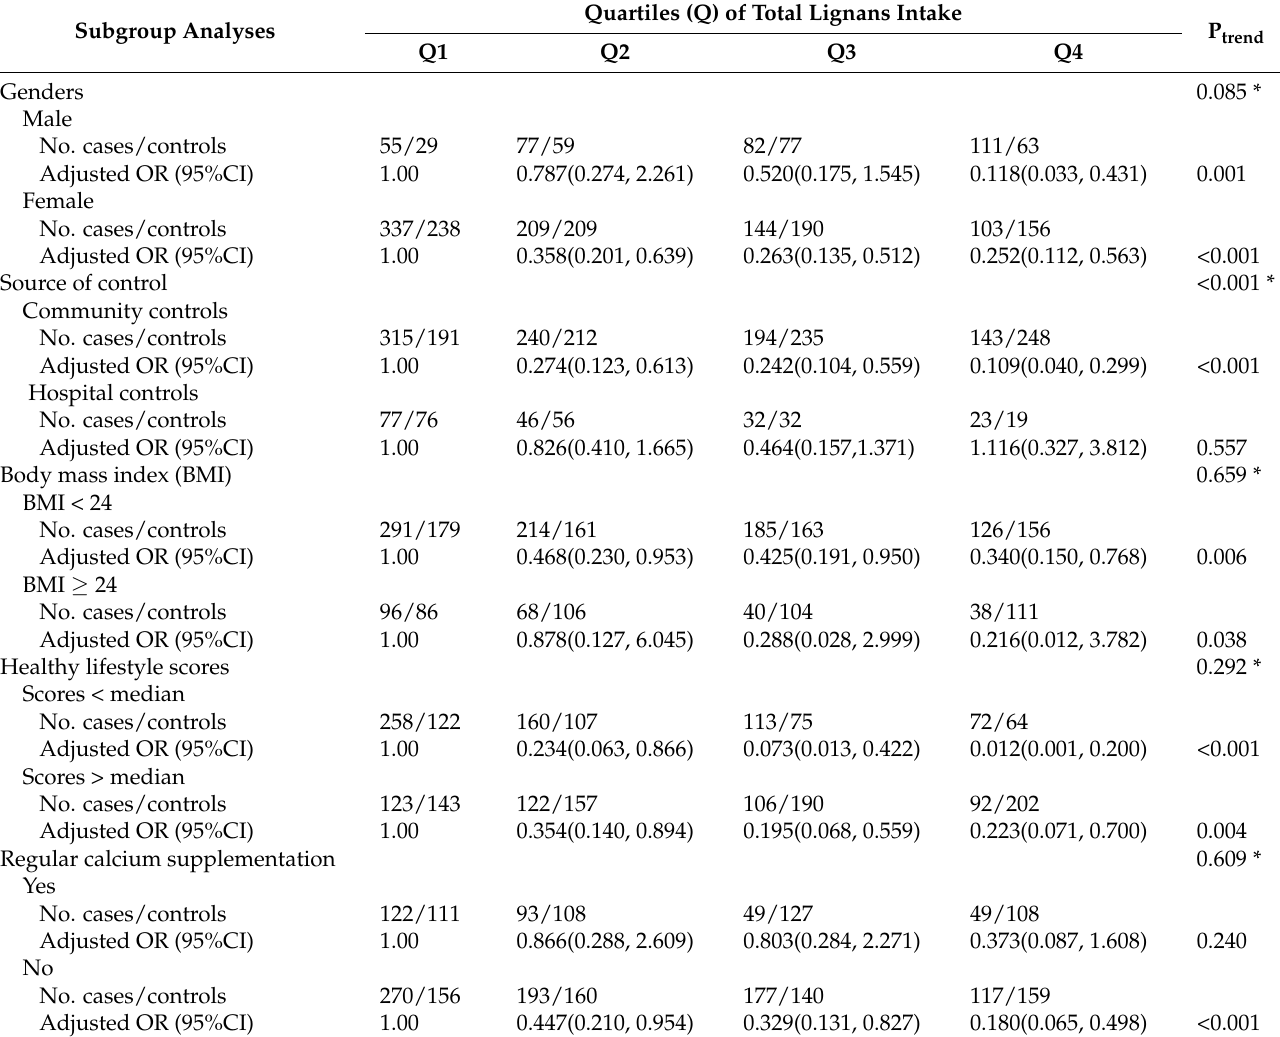
Table 5. Odds ratios (ORs) and 95% confidence intervals (95% CIs) of hip fracture risk for quartiles of dietary total lignans intakes stratified by genders, source of controls, smoking, and alcohol drinking, etc. in Chinese older adults of Guangzhou,